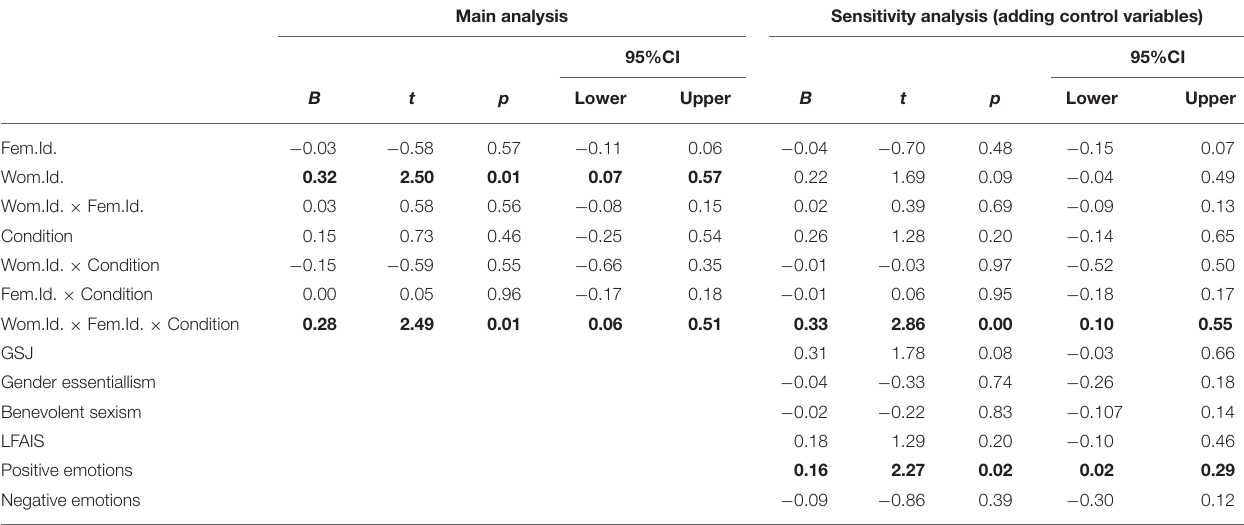
TABLE 4 | Results of the key regression analyses with leadership aspirations entered as the dependent